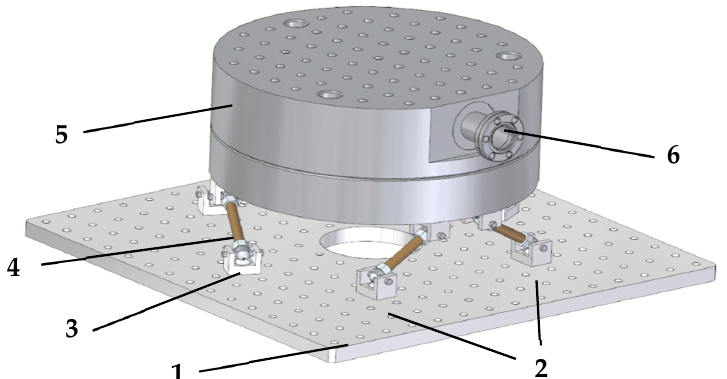
Figure 1. Mechanical design of the cold plate: ( 1 ) Aluminum baseplate; ( 2 ) aluminum hinges; ( 3 ) stainless-steel hollowed acorn nut; ( 4 ) fiberglass epoxy isolating rods; ( 5 ) liquid-nitrogen (LN 2 ) vessel made from 316 stainless steel; ( 6 ) connection flange DN16CF made from 316 stainless